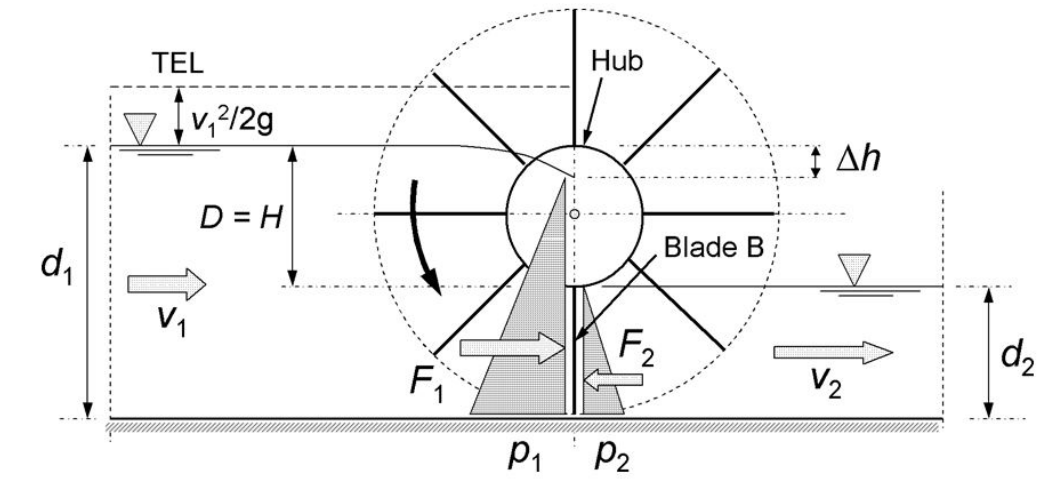
Figure 1. Explanation of the operation of a generic HPM, taken from HYLOW Internal Task Report 2.3